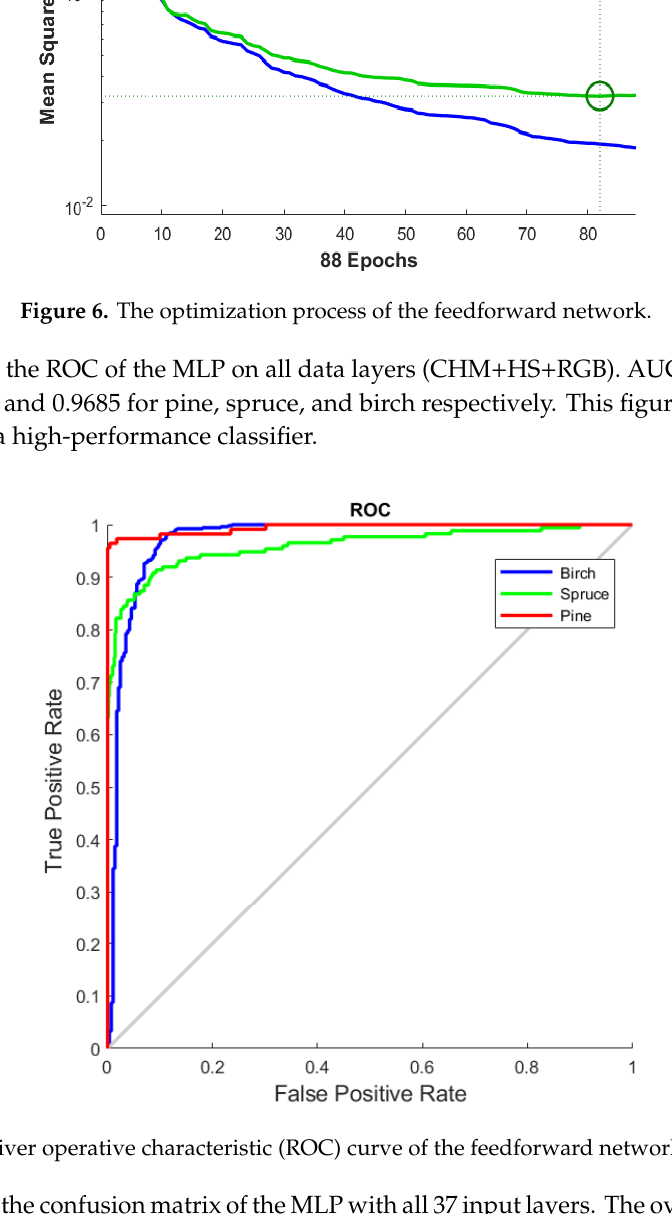
( a ) ( b ) Figure 8. Confusion matrices of the multi-layer perceptron (MLP) with all 37 input layers ( HS+RGB+CHM); ( a ) case numbers, ( b ) normalized percentages.